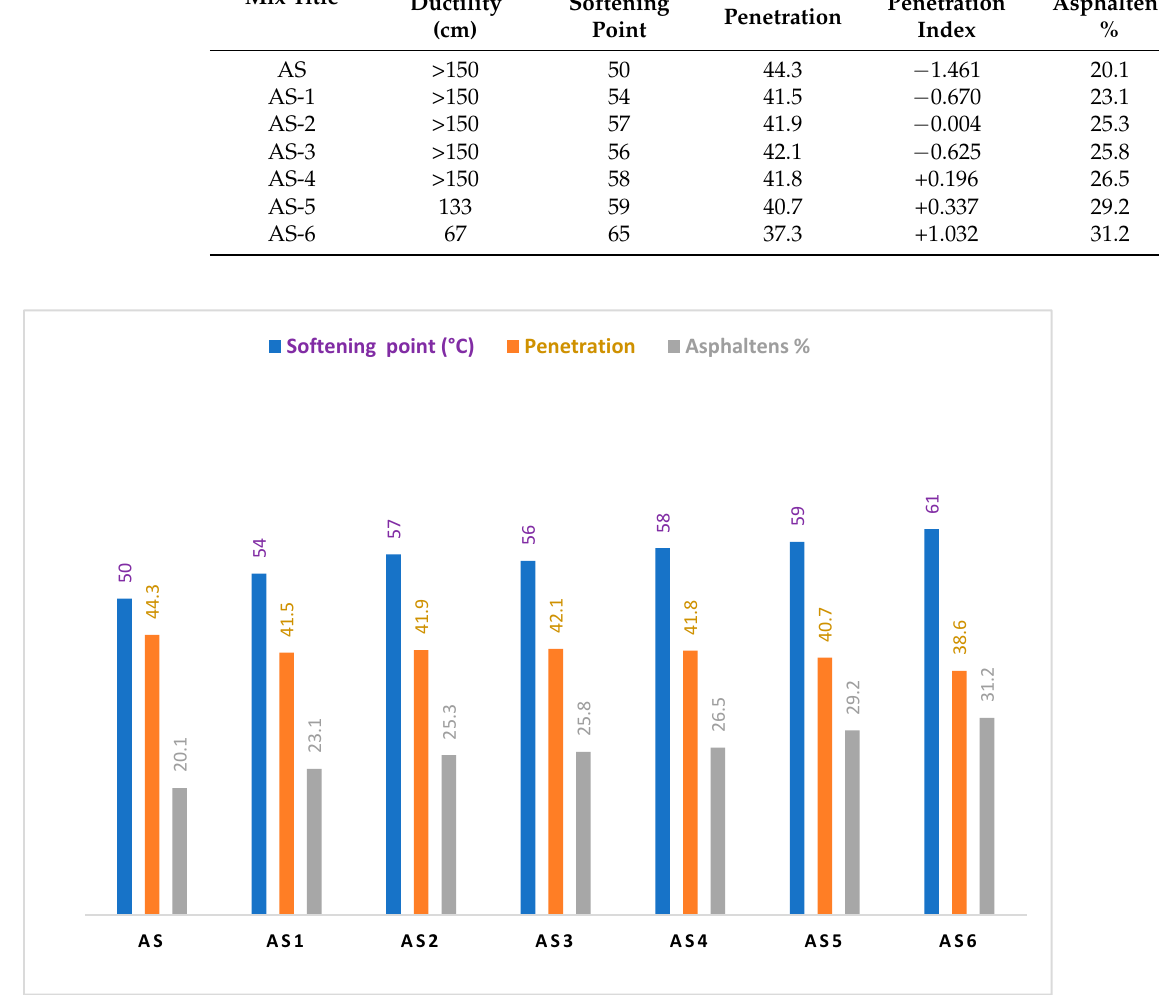
Figure 3. Conventional properties of PW and ULO-modified asphalt pastes.